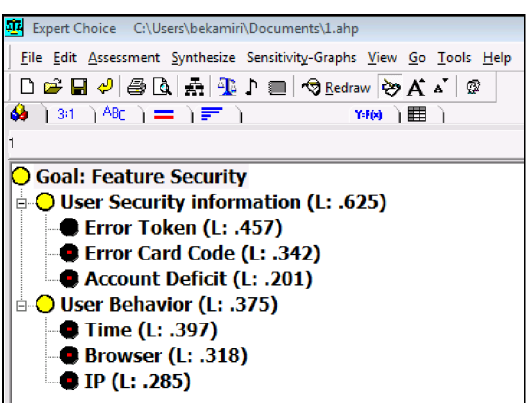
Figure 2. Expert Choice results (source: research analysis).